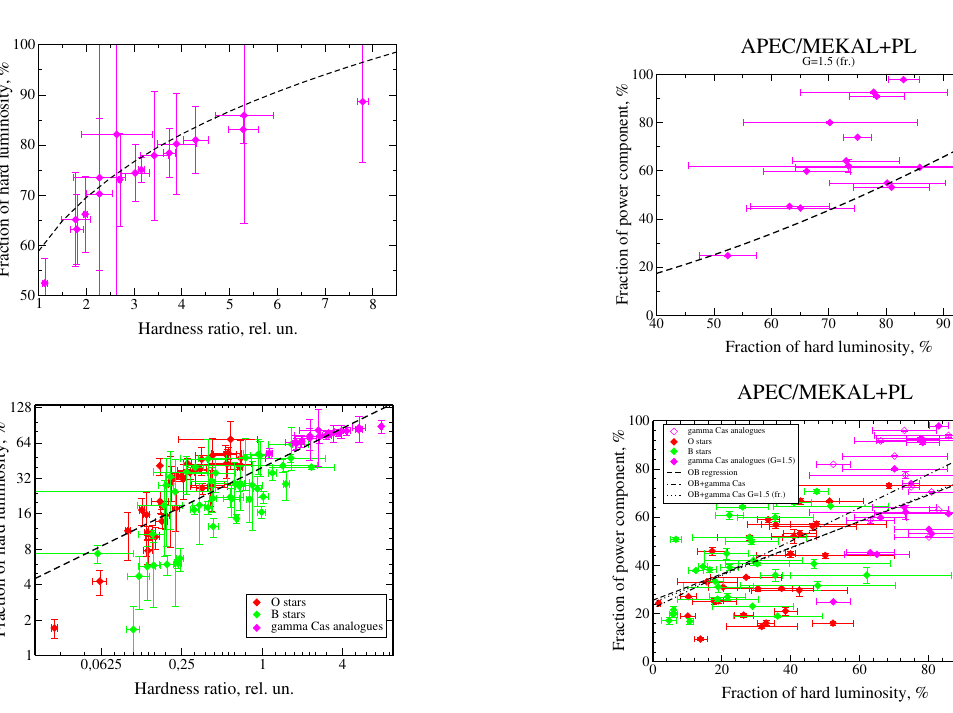
Figure 8. Dependence between the fraction of power component and fraction of hard luminosity for γ Cas analogues ( top panel ) and for typical OB stars together with them ( bottom panel ).